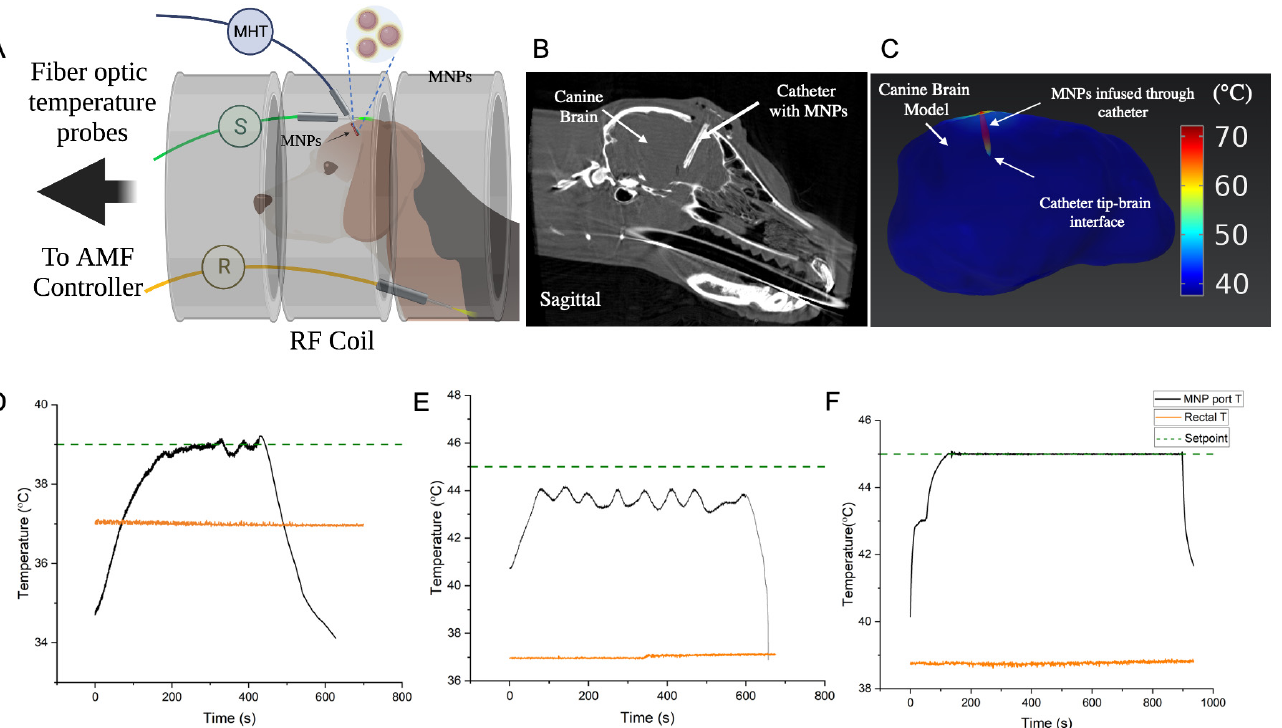
subject. Magnetic nanoparticles (MNPs) (cFe ~ 80 mg Fe/mL, Synomag, Micromod